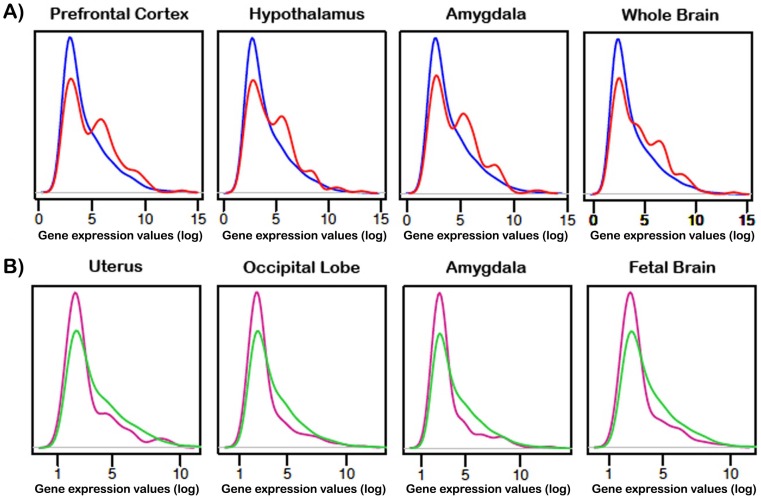
Distribution of the expression levels in A) SRV− genes (blue) and SRVEXT genes (red) and B) PS− genes (green) and PS+ genes (purple) for different tissues.SRVEXT genes show higher expression levels compared to SRV− genes; PS+ genes show reduced expression levels compared to PS− genes.